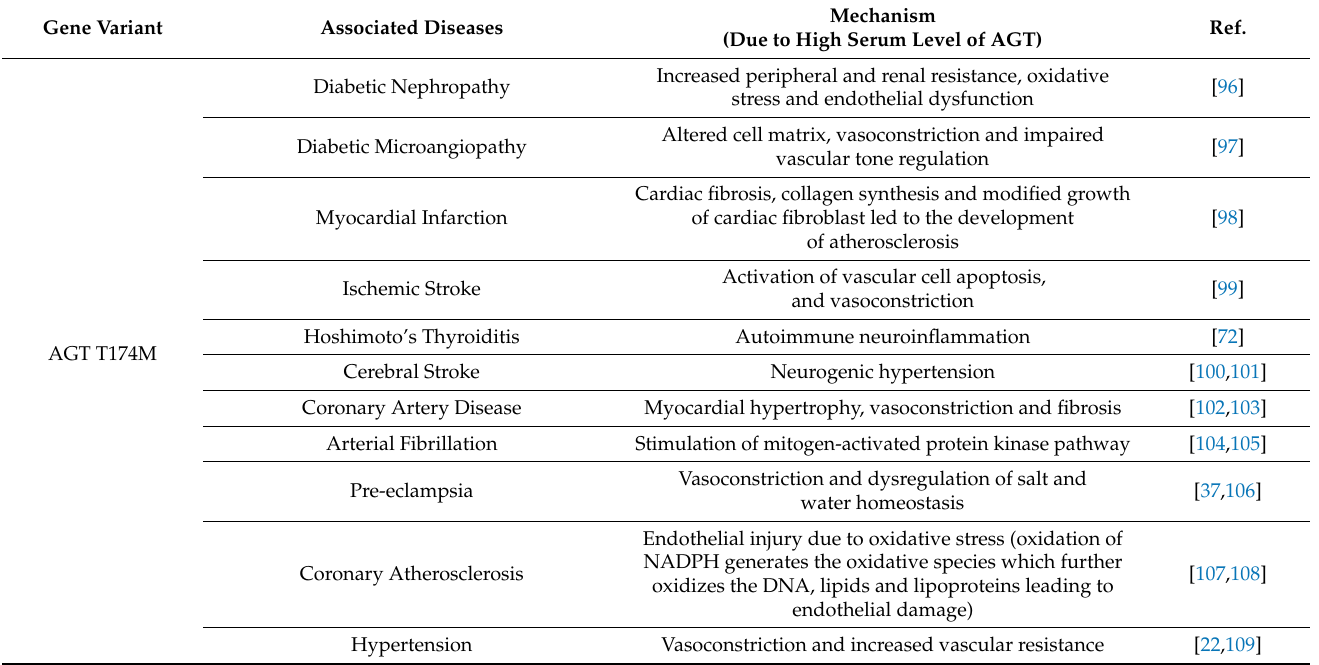
Table 1. Diseases associated with polymorphism of different variants of